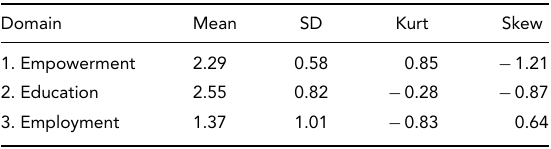
Descriptive Frequencies (N = 841) Domain